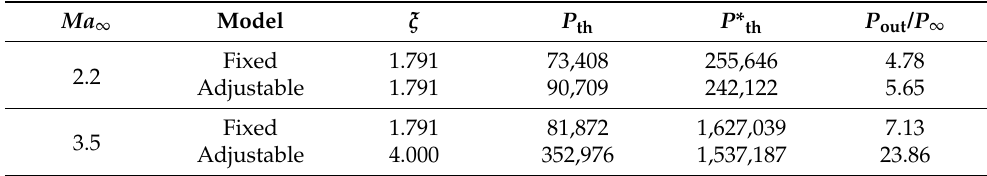
Table 2. Comparison of the resisting back pressure